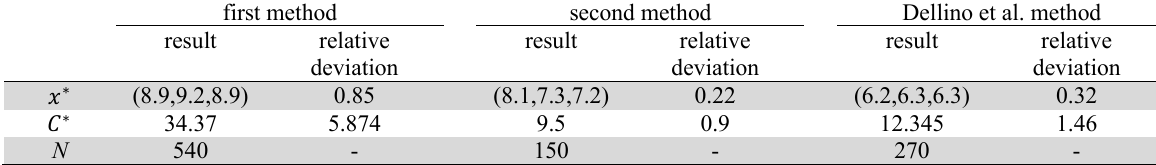
Results and relative deviation from reference for three methods on multi-item newsvendor problem